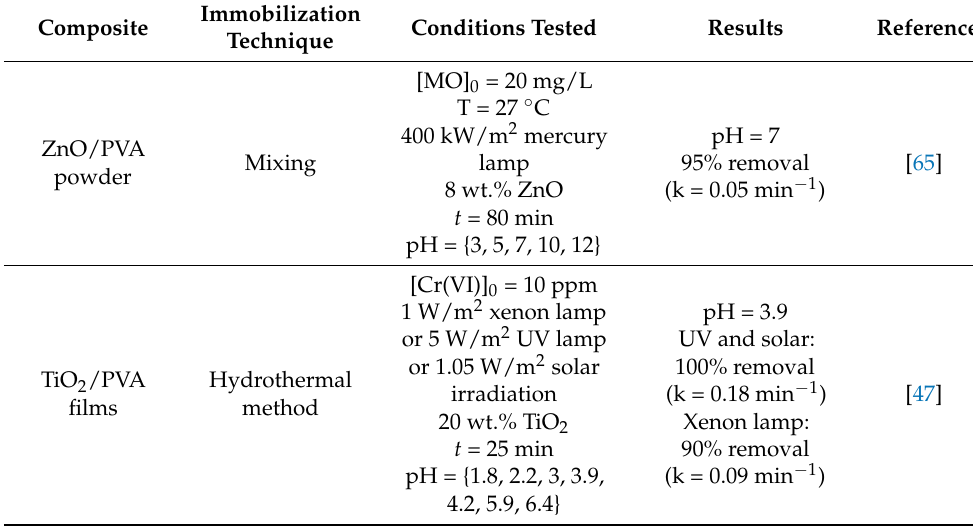
Table 3. Summary of studies that have analyzed the effect of the pH value on the polymer-supported photocatalysis